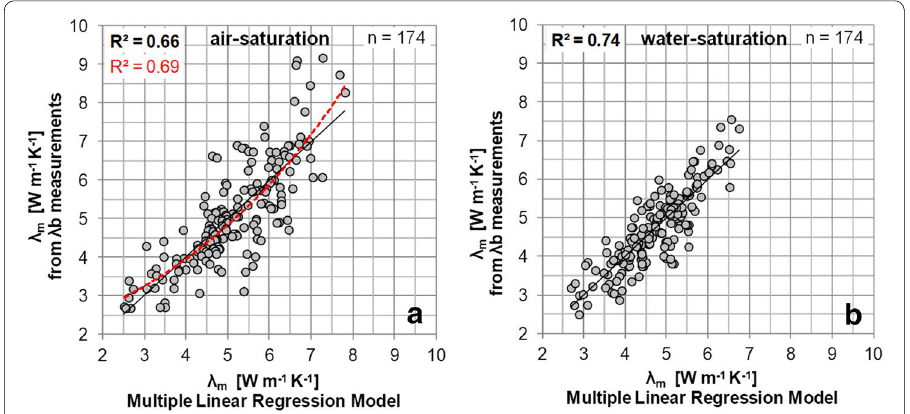
Fig. 5 Cross-plot of λ m calculated from of λ b measurements versus λ m calculations from a linear regression model according to Table 4: a air-saturated conditions and b water-saturated